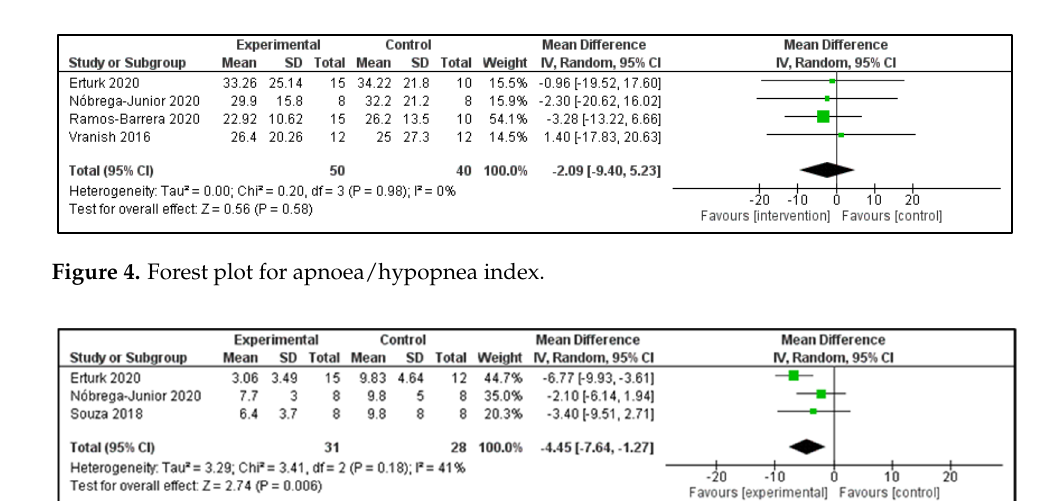
Figure 3. Risk of bias summary.